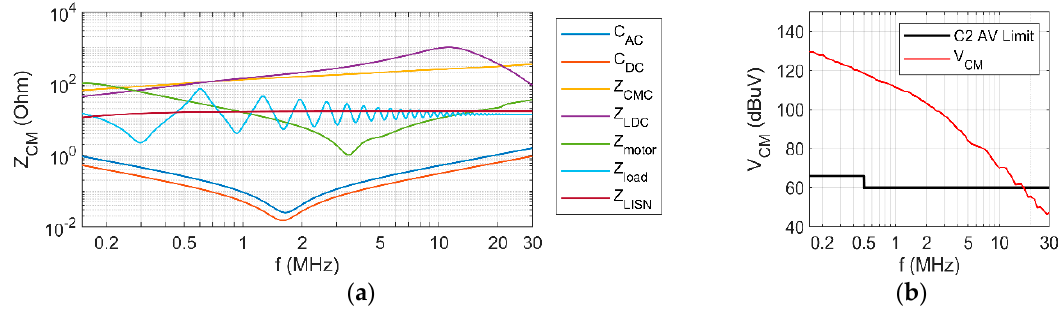
Figure 7. ( a ) The circuit impedances of the equivalent CM circuit shown in Figure 6 with a 100 m motor cable (16 mm 2 ). ( b ) The spectrum of the CM noise source (using AVG detector). The corresponding EMC noise is shown in Figure 5.